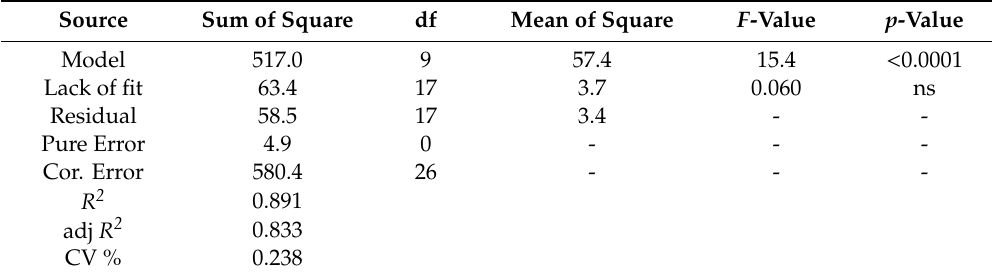
Table 4. ANOVA of the SILM extraction model.